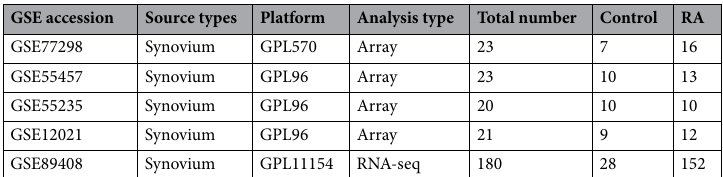
Table 1. Summary of the RA datasets involved in our